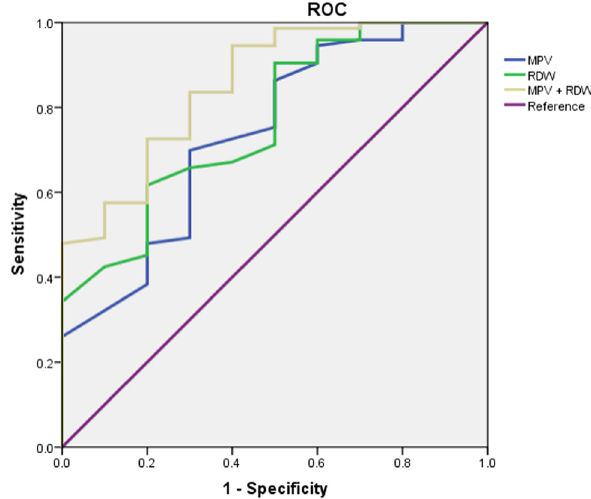
Figure 1: The ROC curve of MPV combined with RDW for the prog - nosis of children with